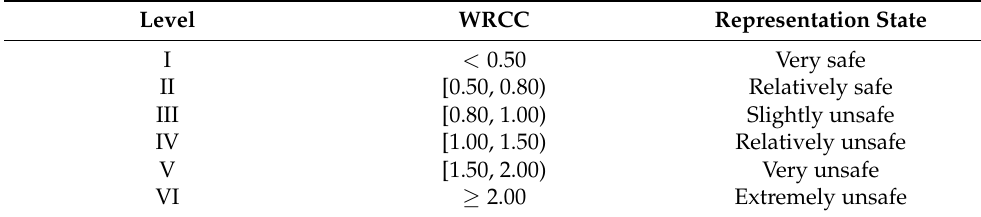
Table 3. Classification of ecological security of water